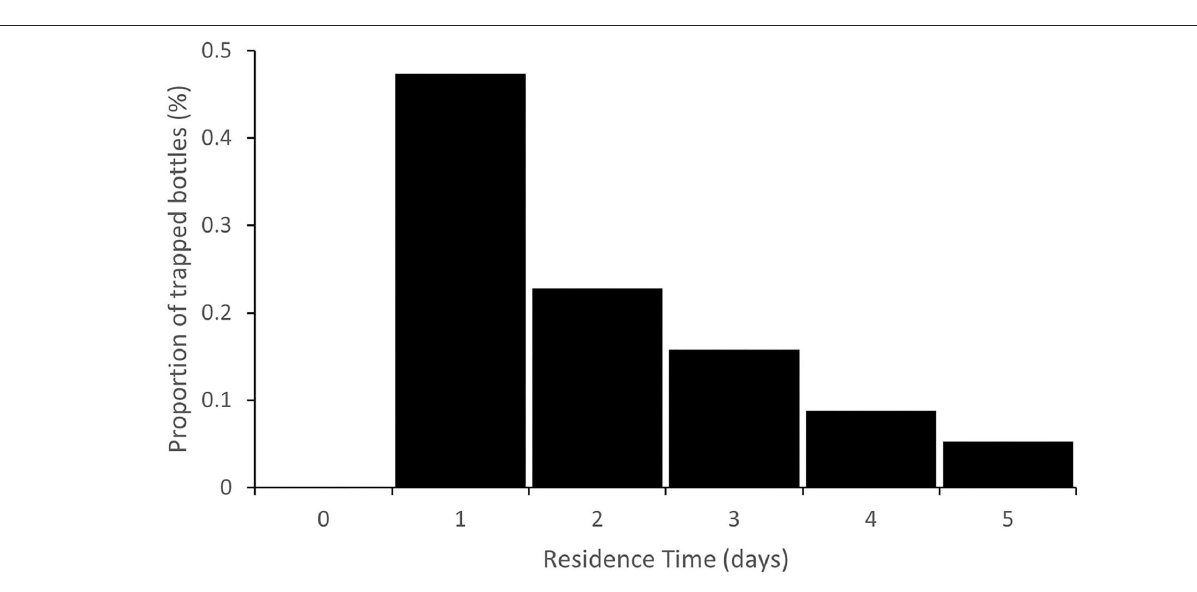
to “real world” spatial patterns of plastic accumulation. In this case, there appears to be a predicted accumulation zone 820 m downstream of the upstream boundary on the second and third days. This zone is not revealed in the measured data from the tracer experiment nor in the Scenario 1 simulations because most bottles are trapped upstream of this point. Long-term surveys and or monitoring of pulse-injected bottles could ascertain whether this point really acts as a zone of preferential macroplastic accumulation or not. In general, the model run in Scenario 2 could be used to target mitigation efforts. With realistic estimates of the location, rate and frequency of emission, model predictions could also be used to estimate riverine plastic fluxes (via n OUT ) at different catchment